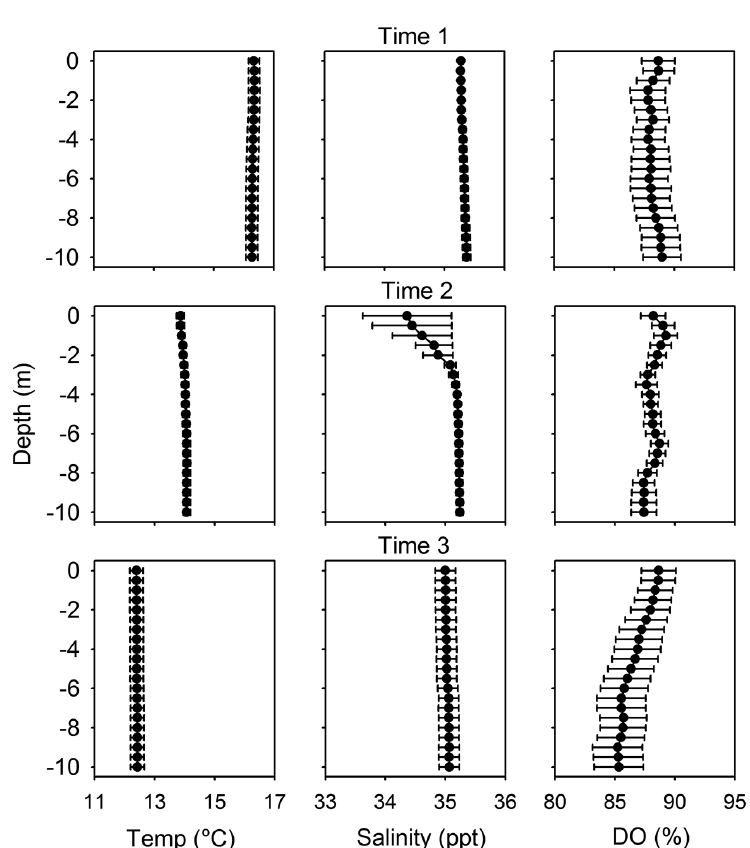
Fig. 2. Temperature, salinity and dissolved oxygen (DO) saturation vertical profiles between 0 and 10 m (mean ± SE, values calculated from 9 cages at 0.5 m intervals) for time 1 (top row), time 2 (middle row) and time 3 (bottom